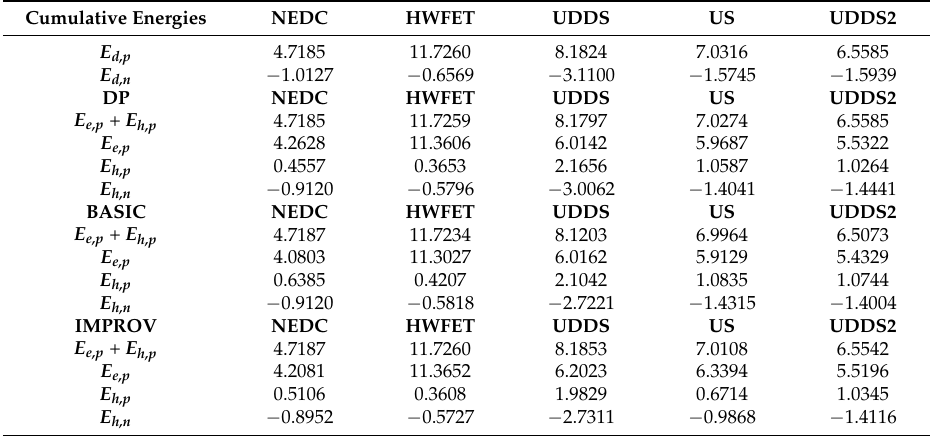
Table 1. Cumulative energies (in [kWh]) on the wheel side for different driving cycles.